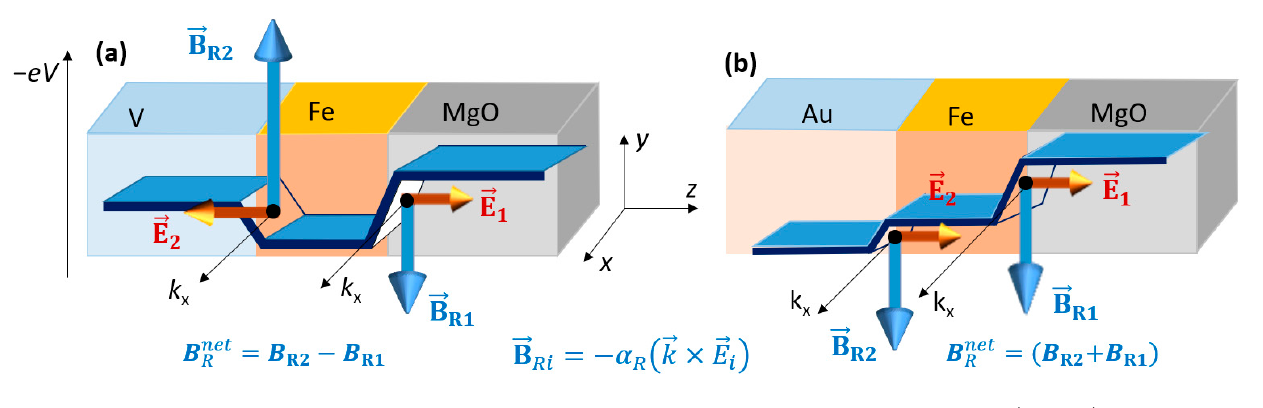
Figure 6. Potential profiles and Rashba magnetic fields 𝐁(cid:4652)(cid:4652)⃗ (cid:3019)(cid:3036) = −𝛼 (cid:3019) (𝑘(cid:4652)⃗ × 𝐸(cid:4652)⃗ (cid:3036) ) related to the intrinsic electric fields 𝐸(cid:4652)⃗ (cid:3036) , i = 1,2 the top (1) = Fe/MgO and the bottom (2) = X/MgO interfaces in ( a ) V/Fe(5ML)/MgO and ( b ) Au/Fe(5ML)/MgO systems–(adapted from [28]). The corresponding interfacial Rashba magnetic fields are 𝐁(cid:4652)(cid:4652)⃗ (cid:3019)(cid:3036) = −𝛼 (cid:3019) (𝑘(cid:4652)⃗ × 𝐸(cid:4652)⃗ (cid:3036) ) , the net (additive) Rashba field felt by the Fe layer, 𝐁(cid:4652)(cid:4652)⃗ (cid:3019)(cid:3041)(cid:3032)(cid:3047) = 𝐵(cid:4652)⃗ (cid:2869) + 𝐵(cid:4652)⃗ (cid:2870) would have a magnitude